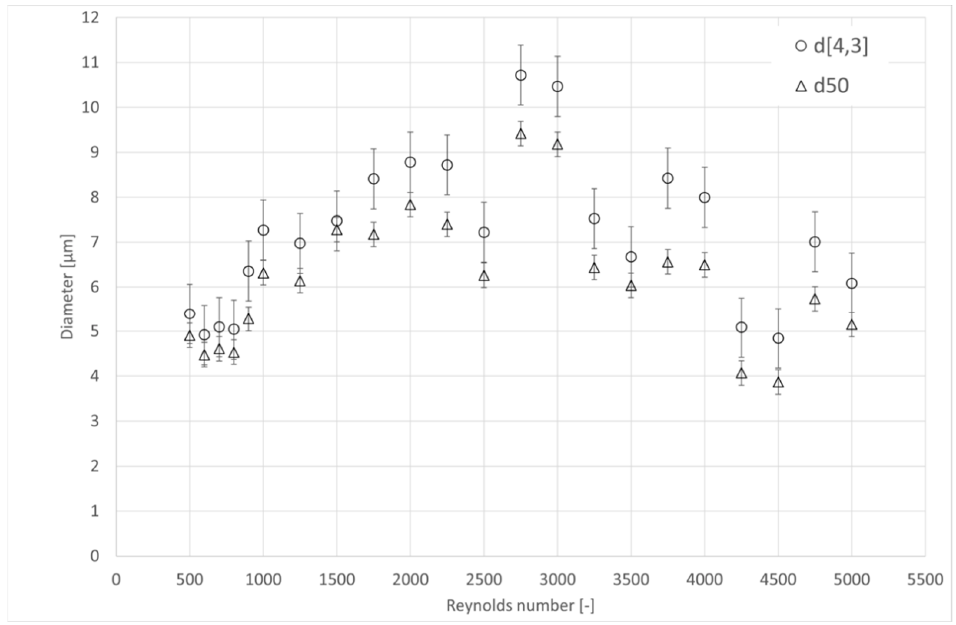
Figure 3. Diameter d 4,3 and d 50 as a function of